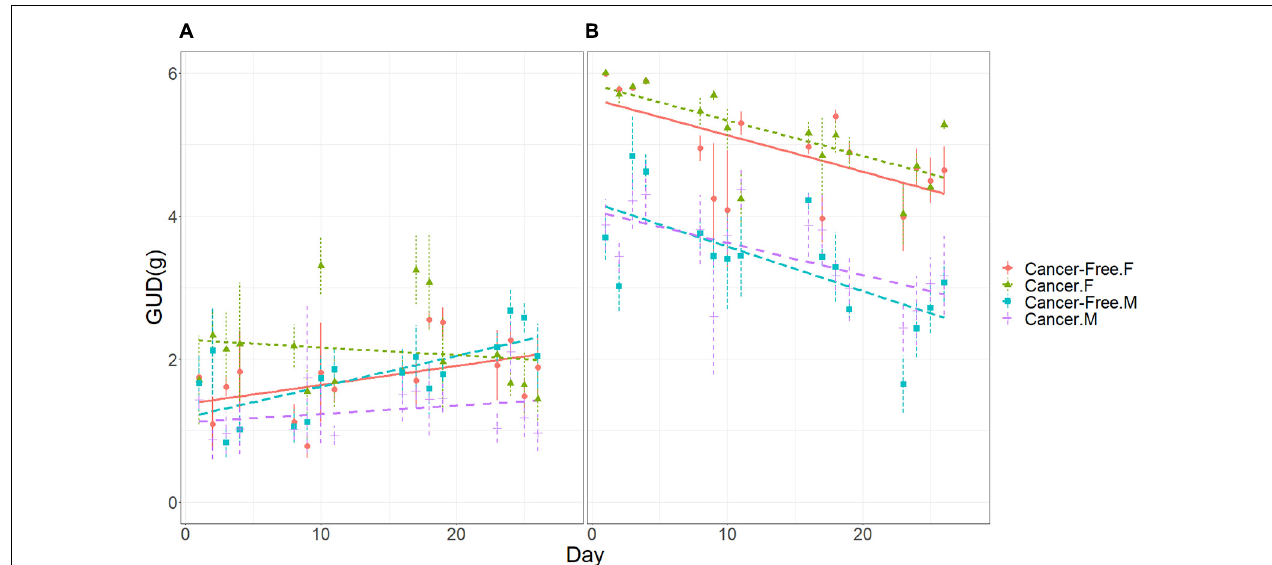
FIGURE 3 | Giving-up densities (GUDs) of mice in the vivarium according to cancer treatment, sex, and date. (A) Bush microhabitat. (B) Open microhabitat. Error bars represent standard errors of the